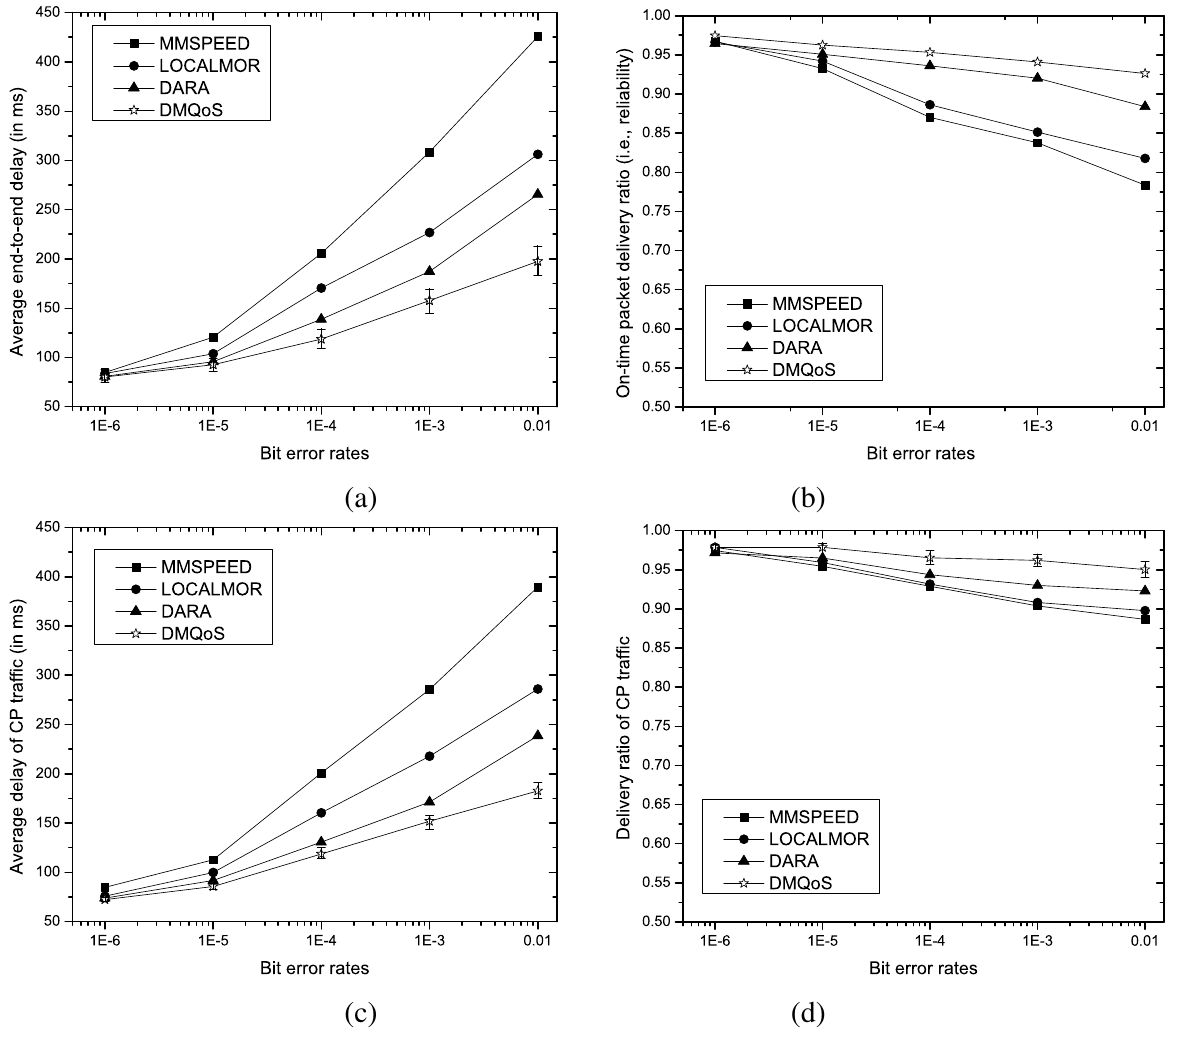
Figure 4. Performance comparisons for varying bit error rates- (a) average end-to-end delay of all data packets, (b) on-time packet delivery ratio, (c) average delay of CP traffic and (d) reliability of CP